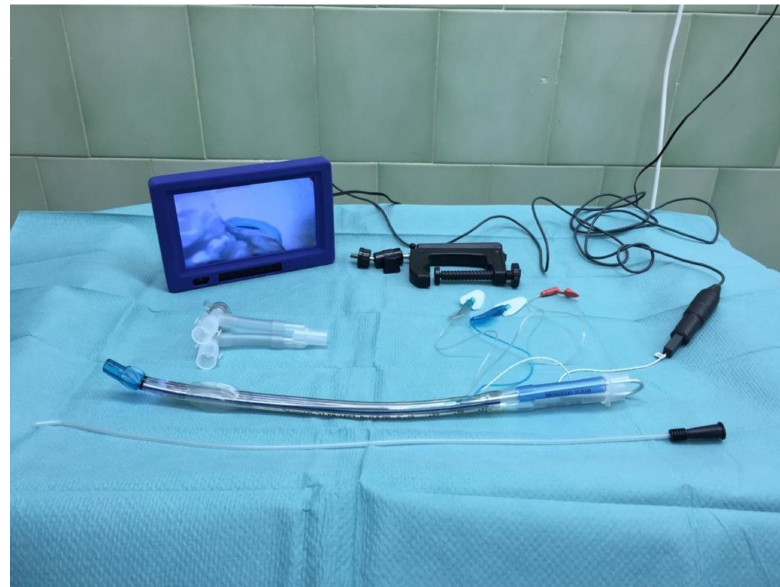
Figure 6. The fiberoptic double-lumen tracheal